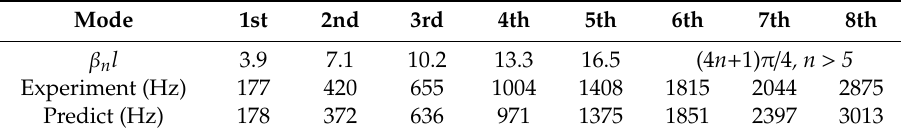
Figure 7. Signal processing of vibrational response of gauge plate: ( a ) time response excited by water and ( b ) frequency responses. Table 1. Comparison of the measured and predicted natural frequencies.